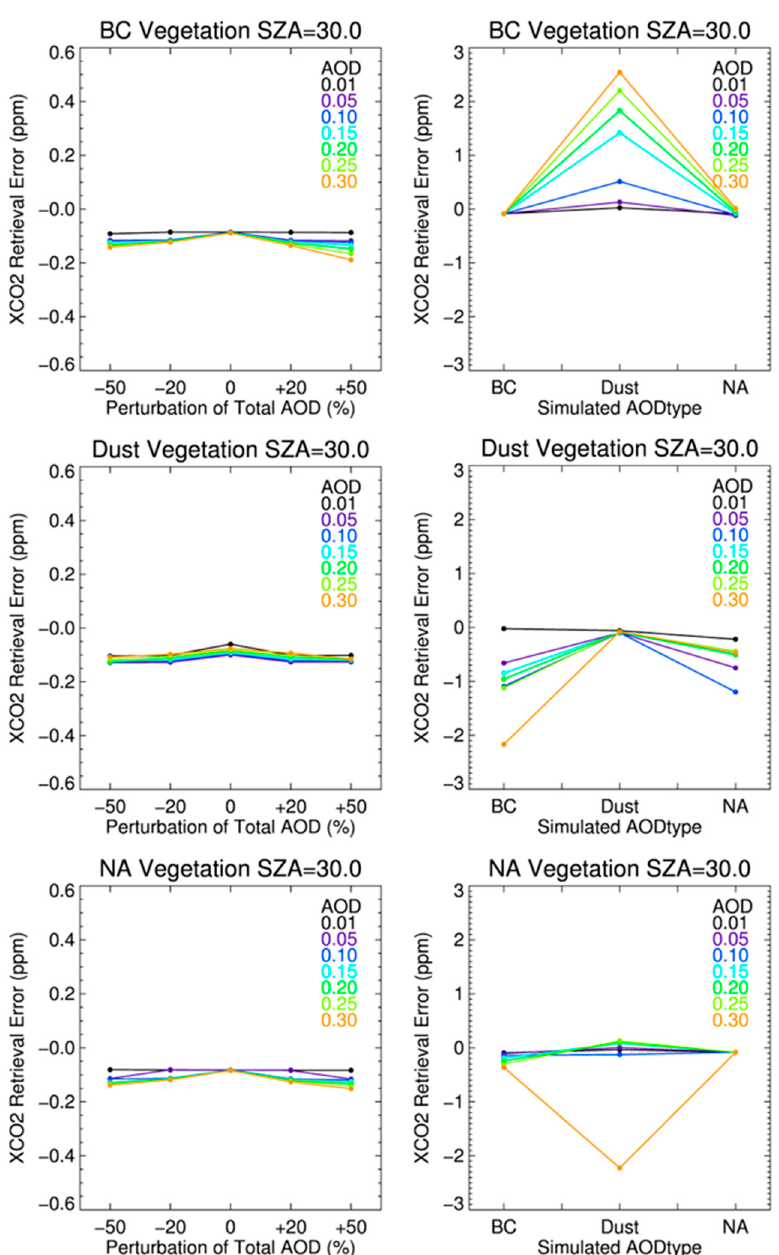
Figure 6. Same as in Figure 5, except for the perturbed total AOD ( left column) and information in aerosol type ( right column), respectively.